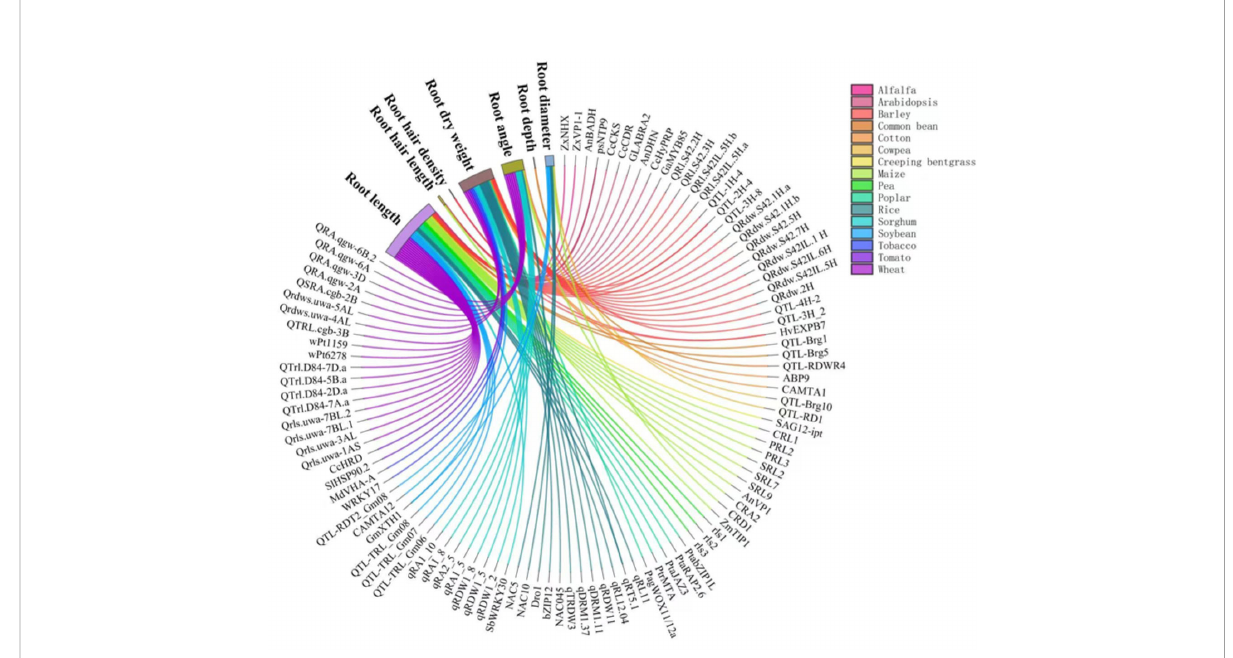
FIGURE 3 Genes and QTLs involved in the drought responses of root traits in different plant species reported in the literature. Different colors of lines and fl ows represent different crops. Data and references are included in Supplementary Table 1 and Supplementary File 1,